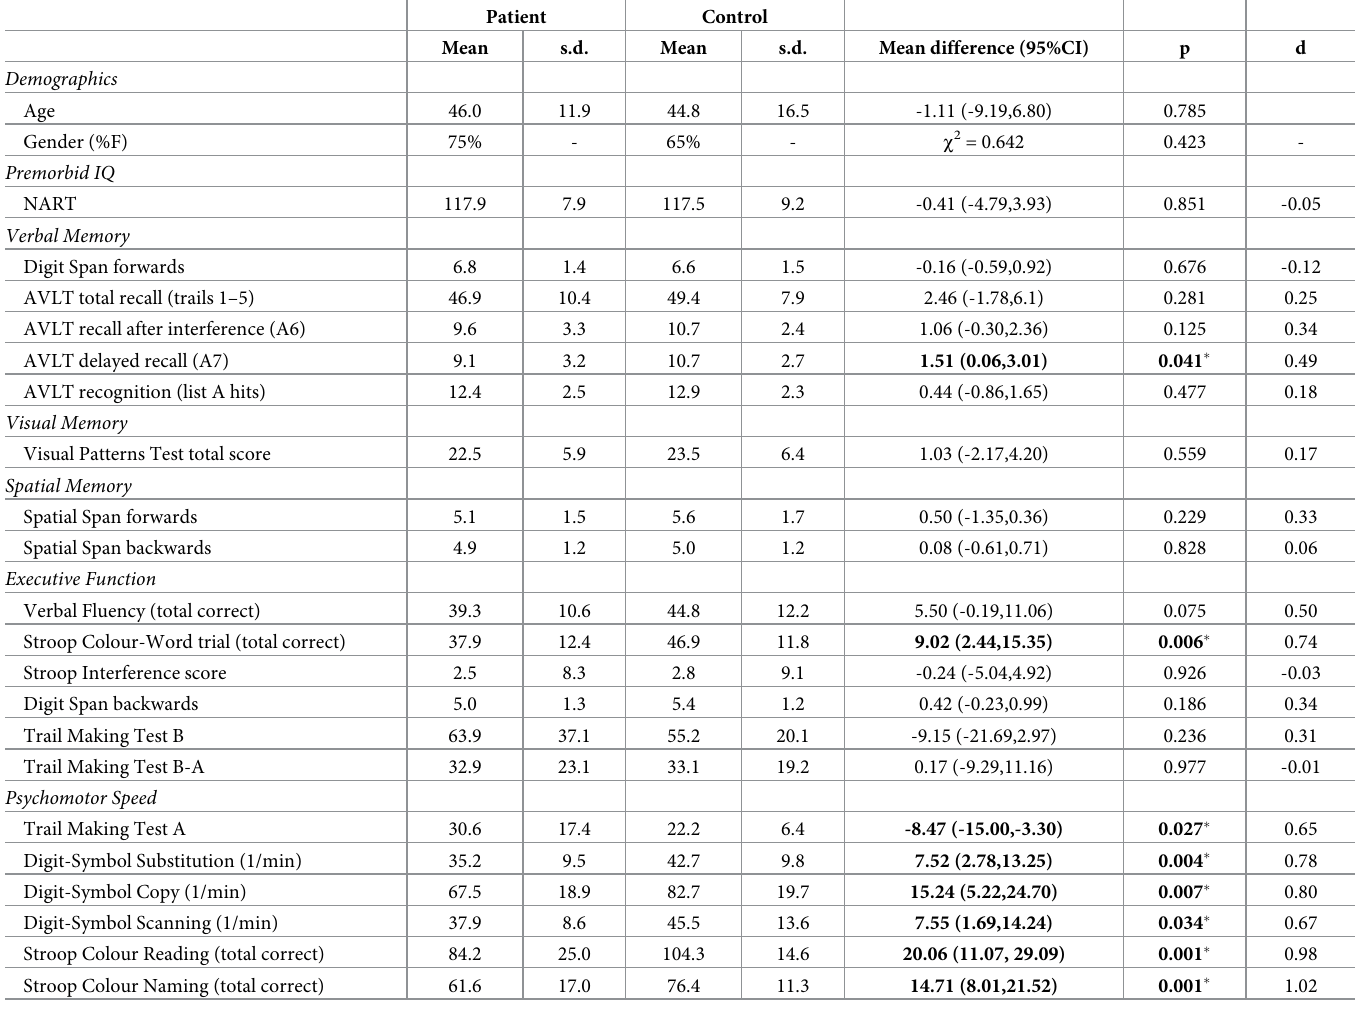
Table 2. Phase 2 demographics and neuropsychological test